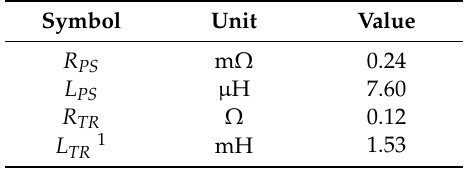
Table 3. Computed resistances and reactances of the power system and unit